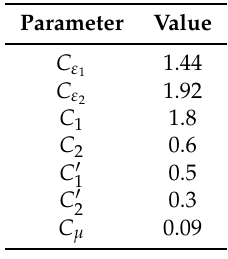
Table 1. Parameter values used for turbulence definition using Reynolds stress model.